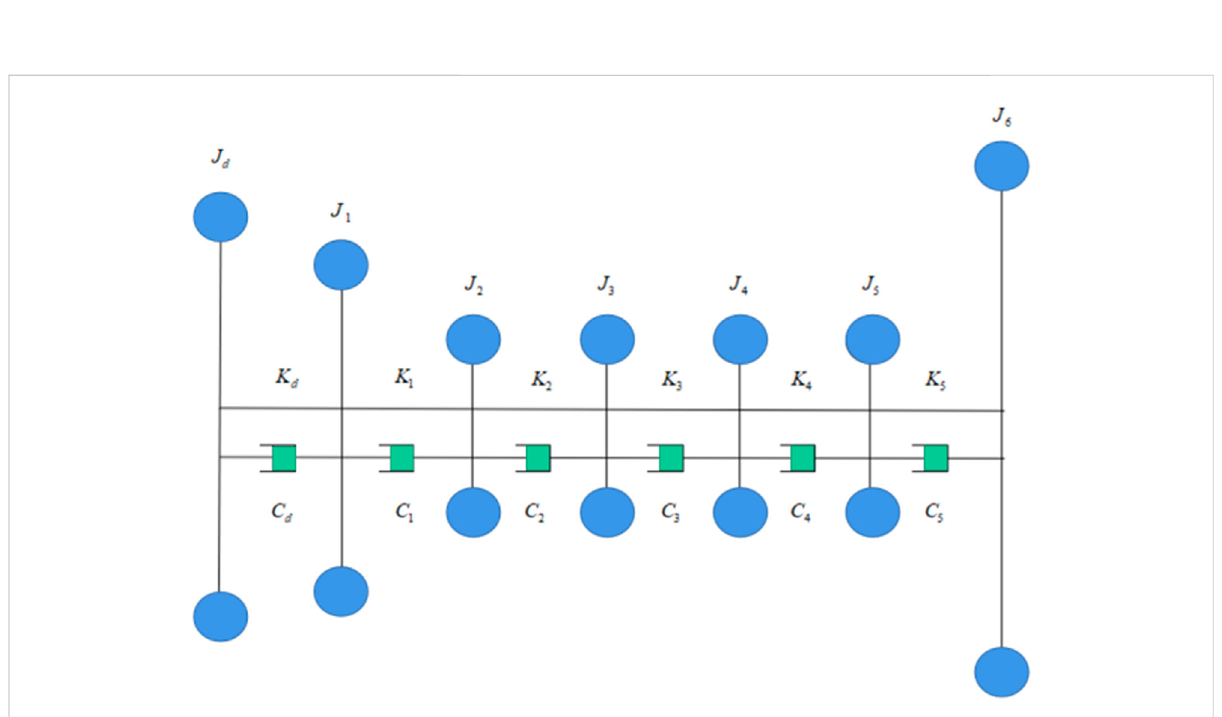
FIGURE 6 Equivalent model of crankshaft system torsional